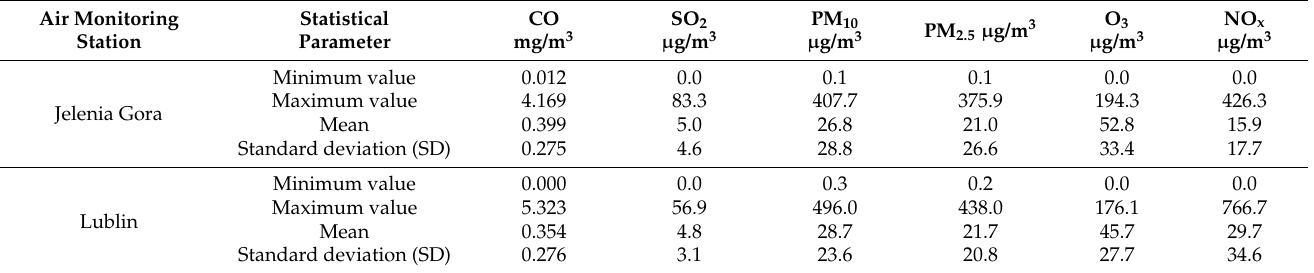
Table 3. Statistical description of measured variables at the air monitoring stations,